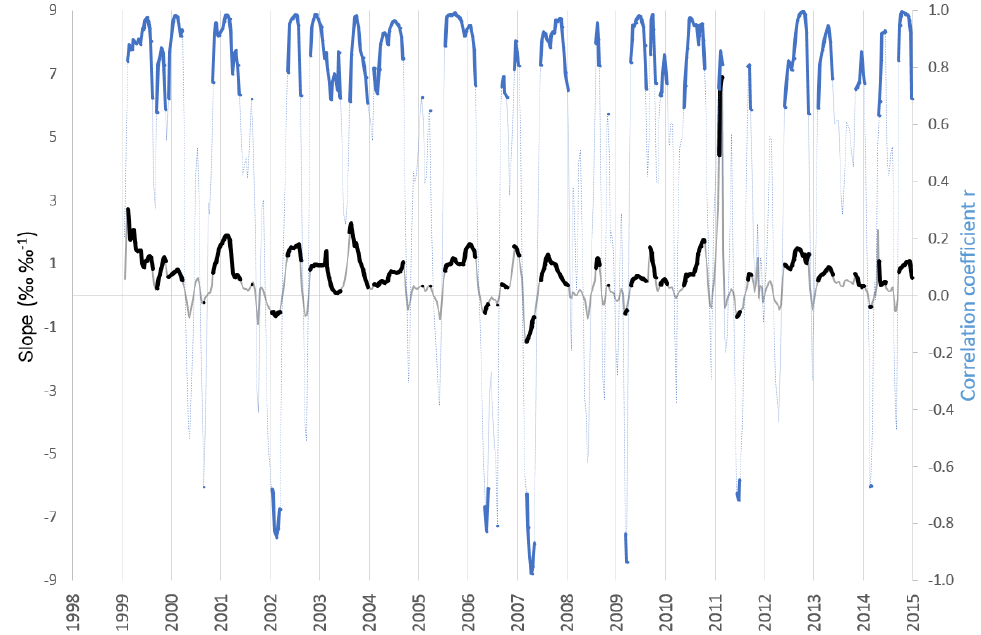
Figure 11. The 10-point running slope (‰‰ − 1 ) and running correlation coefficient calculated between d -excess versus δ 18 O calculated from the raw data of TA192A. Significant results are indicated by thick lines ( p < 0 . 05). The date associated with the results corresponds to the first point of the regression calculation (applied to 10